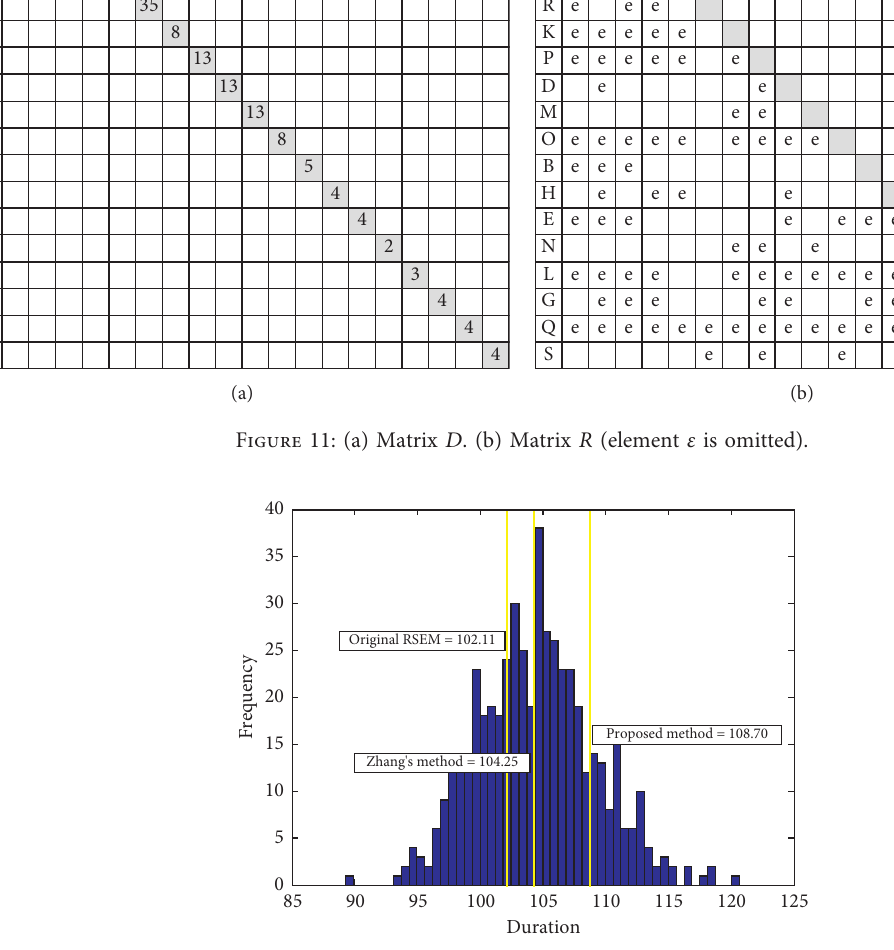
Figure 12: Simulated actual project